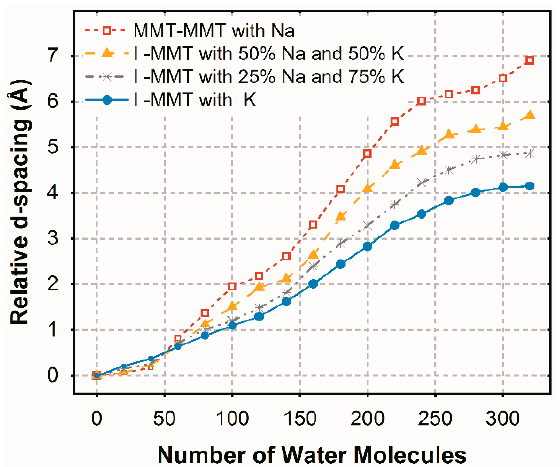
Figure 3. Comparison of the relative d-spacing as a function of the water content for I − MMT MLC with 50% Na + and 50% K + (yellow), I − MMT MLC with 75% K + and 25% Na + (gray), I − MMT MLC with K + only (blue), and MMT − MMT with Na + only (red).